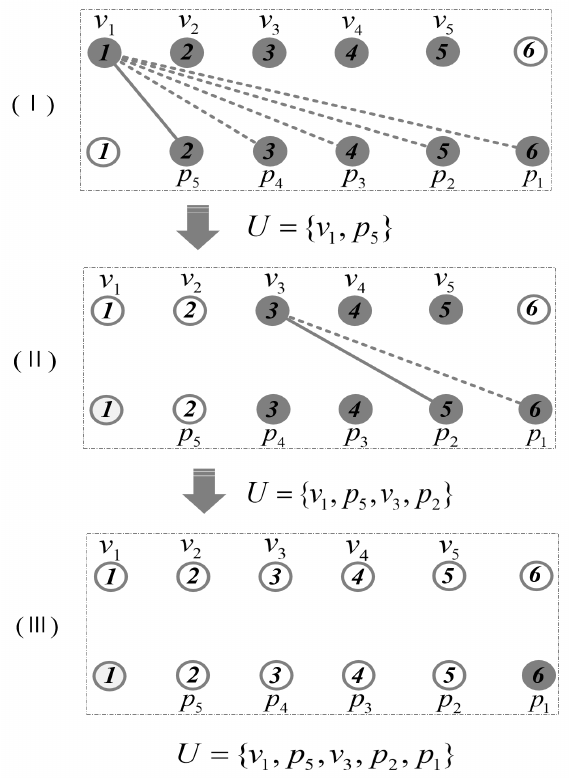
Figure 4. First pruning of the path, ( I ) shows the point v 1 and the point p 5 are connected successfully; ( II ) shows the point v 3 and the point p 2 are connected successfully; ( III ) shows no point can connect